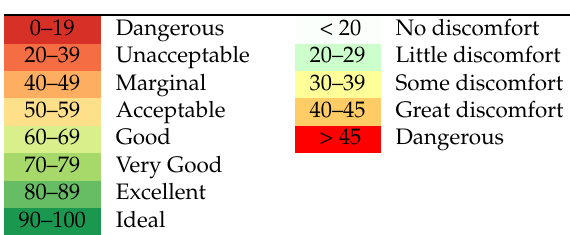
Table 7. HCI and Humidex color